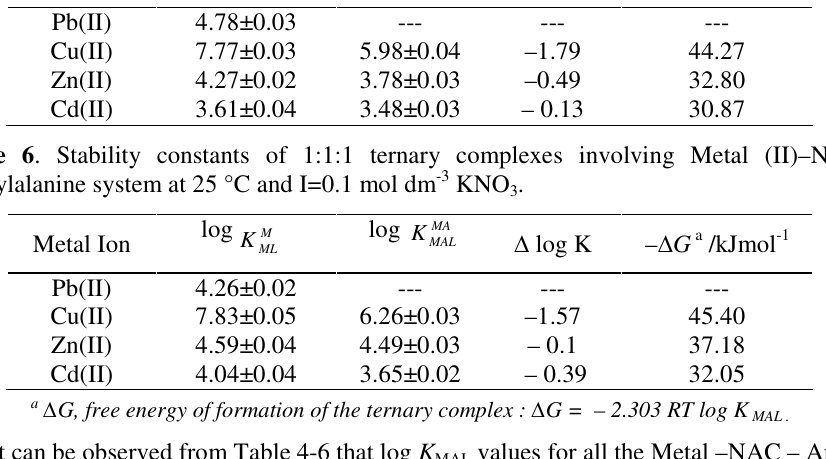
Table 5 . Stability constants of 1:1:1 ternary complexes involving Metal(II)–NAC–Tyrosine system at 25 °C and I=0.1 mol dm -3 KNO